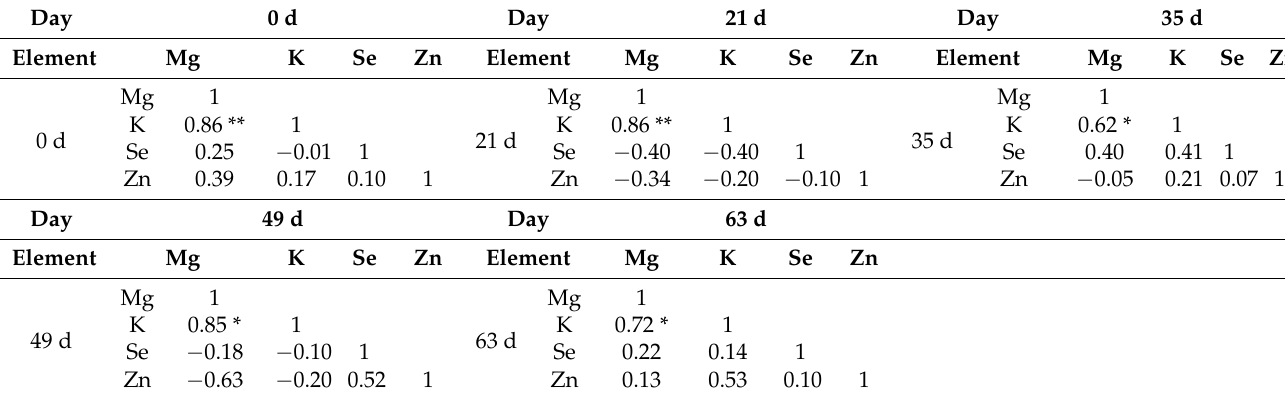
Table 3. Correlation between the depositions of mineral elements in the breast muscle.